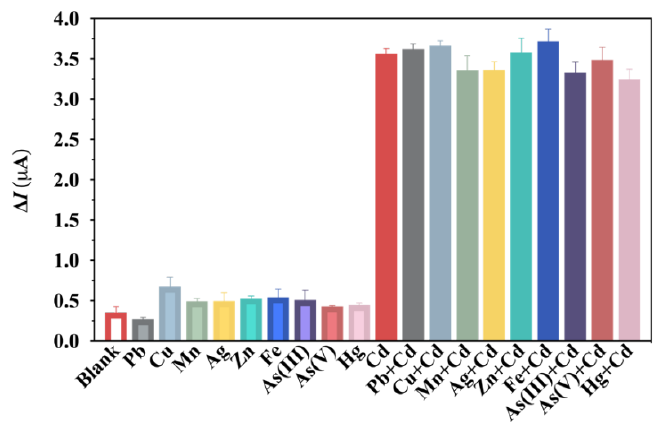
Figure 5. Selectivity of the aptasensor for Cd 2+ determination. The concentrations of interfering ions were 50.0 ng/mL, and Cd 2+ concentration was 2.0 ng/mL.